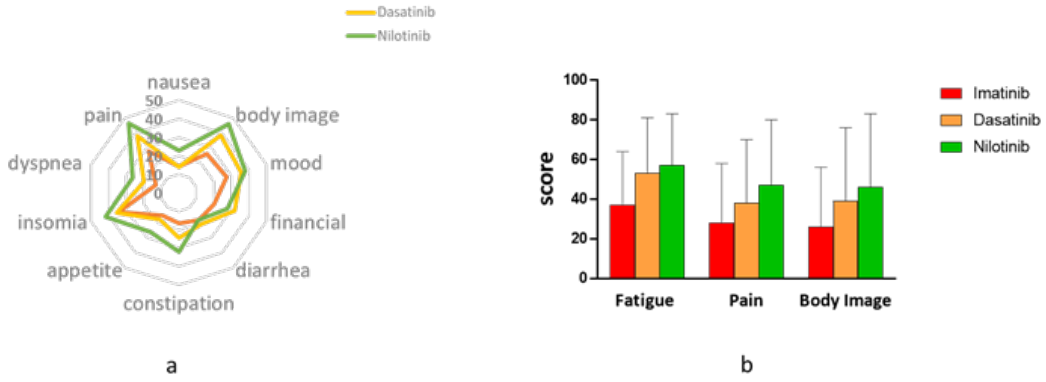
Figure 1. Symptom Burden on imatinib vs. dasatinib and nilotinib. Symptom burden according to EORTC QLQ-C30 and EORTC QLQ-CML24 in patients on imatinib, dasatinib or nilotinib. ( a ). A polar plot summarizes scores of 10 symptom-related items/scales. Higher scores represent worse symptomatology. As shown, patients on